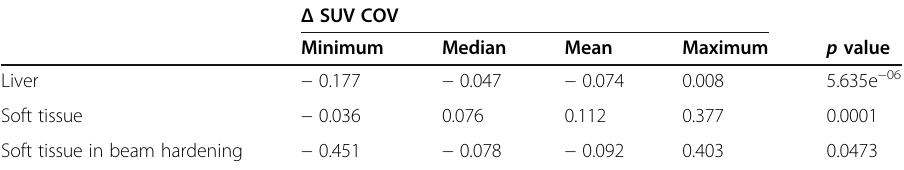
Table 2 Minimum, median, mean and maximum Δ SUV COV for ROIs in FBP compared to IR reconstructed datasets and p values for comparison of paired SUV COVs Δ SUV COV Minimum Median Mean Maximum p value Liver − 0.177 Soft tissue − 0.036 Soft tissue in beam